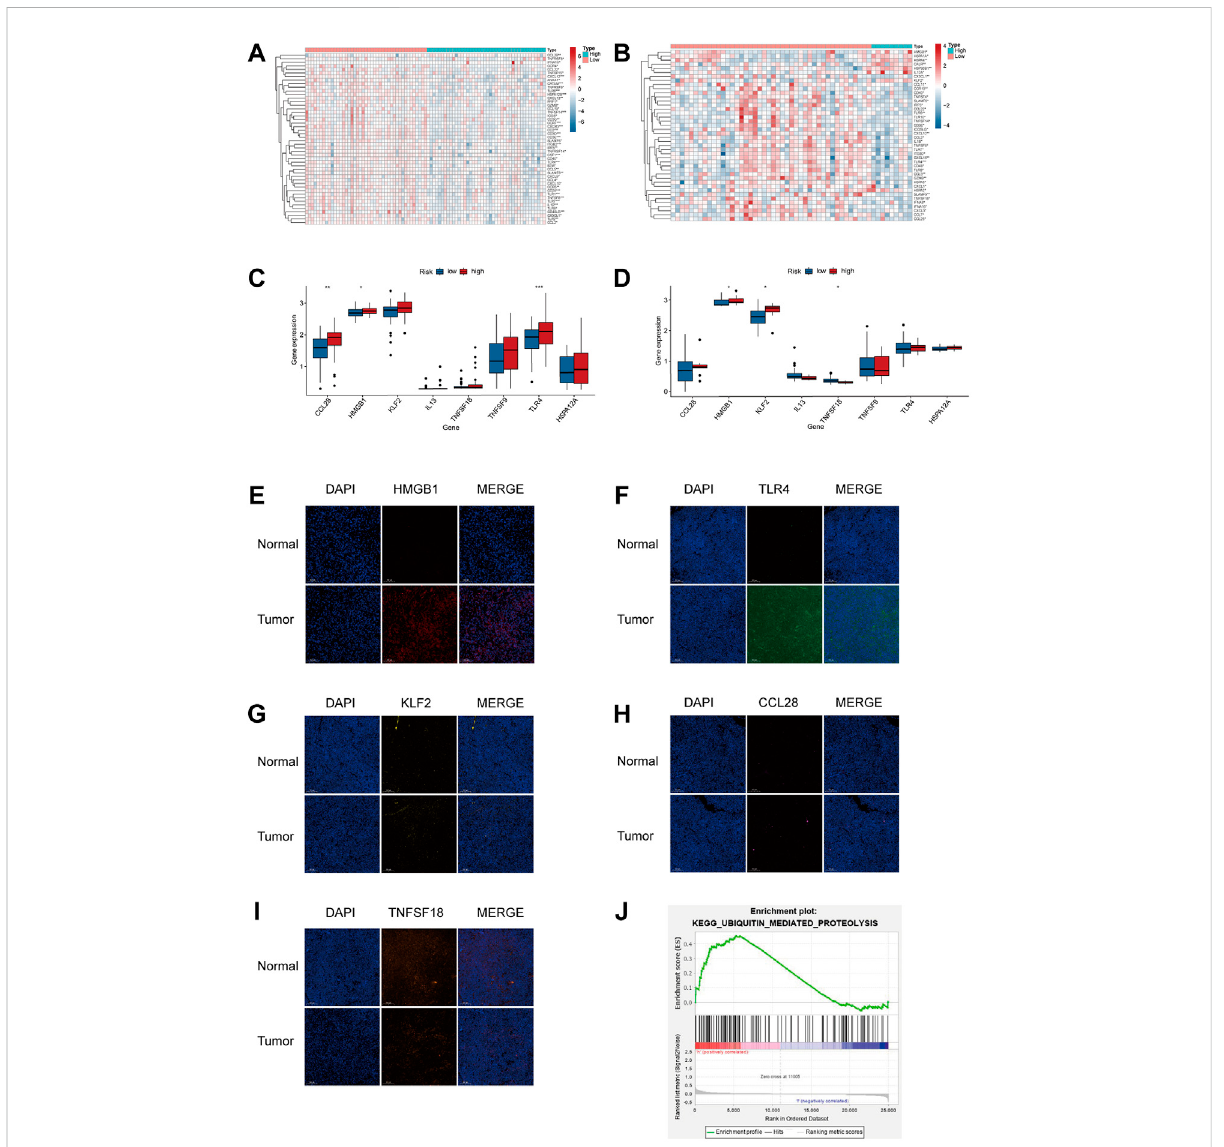
FIGURE 6 TIM of the high hypoxia risk group exhibited immunosuppressive characteristics. (A,B) Heatmap showing the positively regulated genes of the Cancer-ImmunityCycleintwosubtypesinthetraining (A) andtesting (B) databases. (C,D) Expressionofimmune-relatedsignatureinthetrainingand testing dataset. (E – I) Expression of immune-related regulators were veri fi ed by immuno fl uorescence in tumor and normal tissues. (J) GSEA in TARGET cohort. *** p <